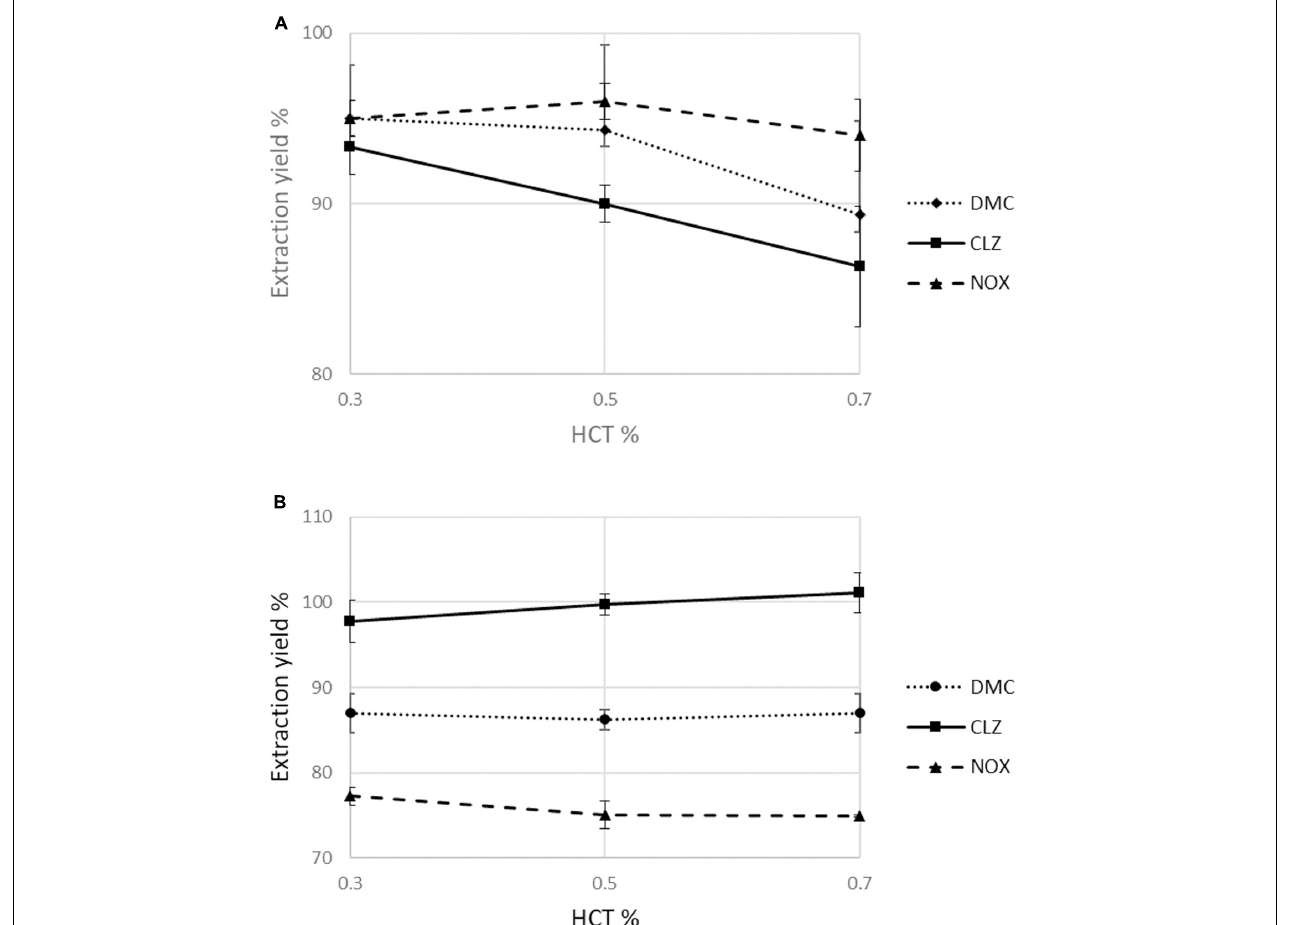
FIGURE 3 | Assessment of the effect of hematocrit values (0.3, 0.5, and 0.7) on mean percentage extraction yields in (A) b-VAMS and (B) mfDBS.